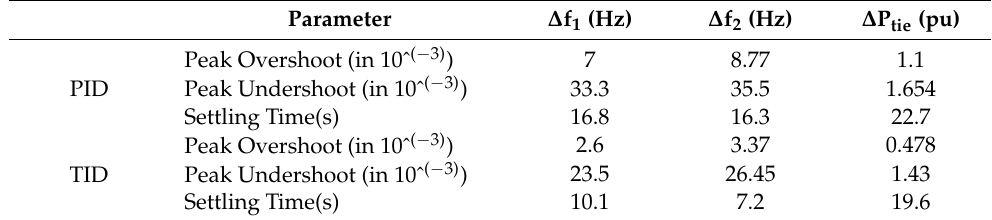
Table 16. TID parameters for the combined AGC and AVR system.